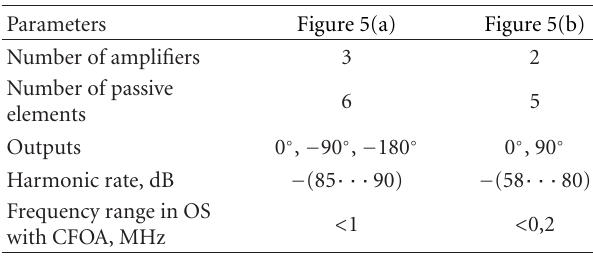
Table 2: Comparison of circuits with two